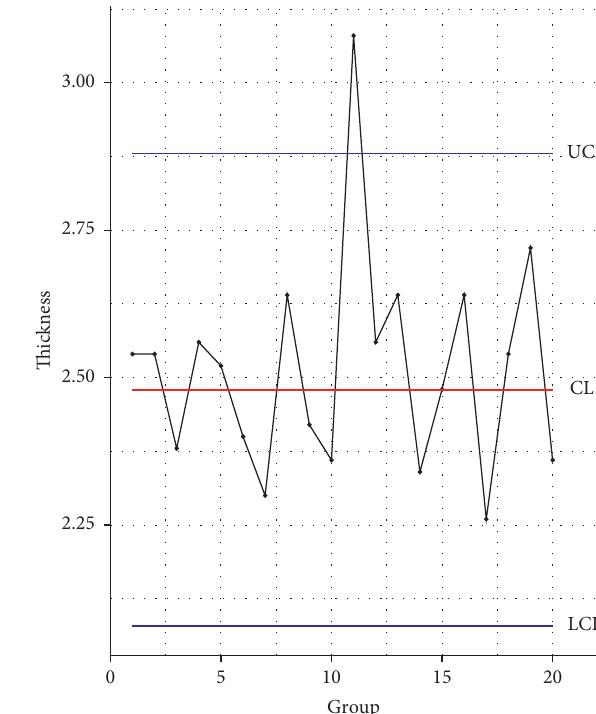
Figure 4: Gompertz Shewhart X control chart.